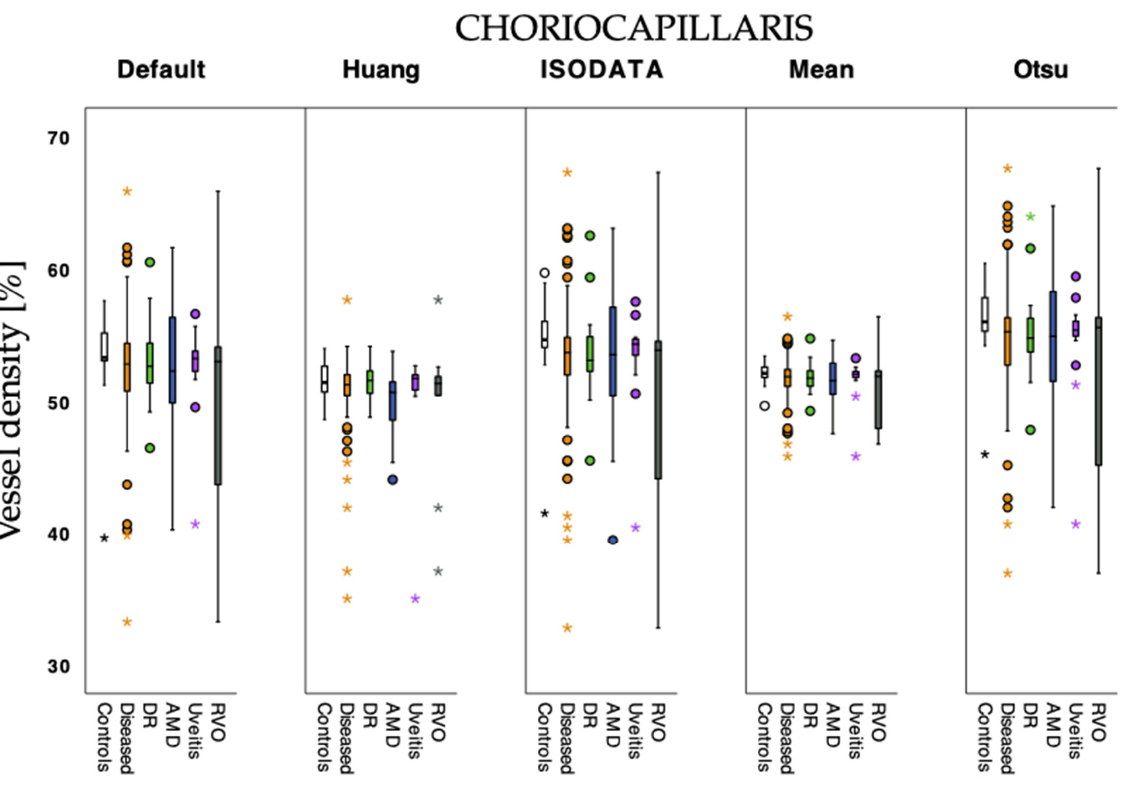
Figure 3. Vessel density values calculated with the tested algorithms for control and diseased eyes in choriocapillaris angiograms. Subgroups of diabetic retinopathy (DR), age-related macular degeneration (AMD), uveitis, and retinal vein occlusion (RVO) were also considered. Circles: outliers of 1.5 times the interquartile range of quartile 1 or quartile 3; stars: extreme outliers of 2.5 times the interquartile range of quartile 1 or quartile 3, respectively.